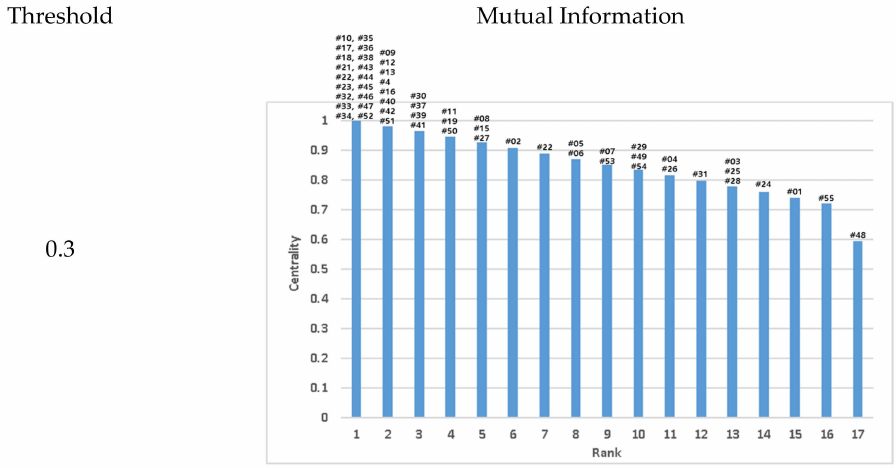
Figure 7. Estimation of centrality and rank of station by Pearson correlation: The X -axis mean the rank of station and the Y -axis is the values of centrality. The number upon the bar mean the stations which belong to the